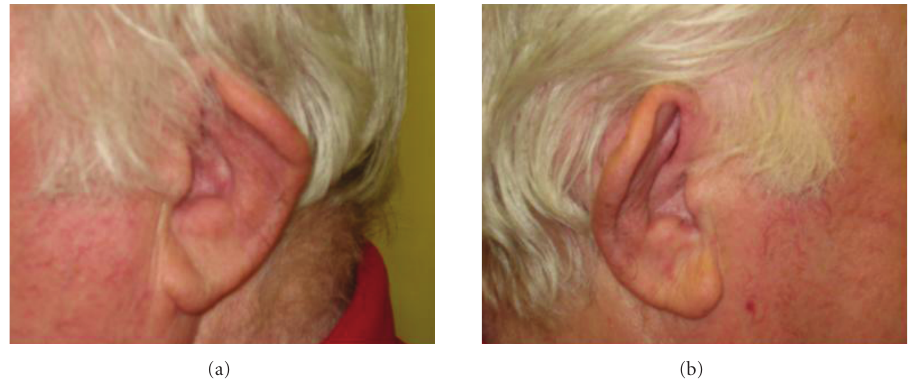
Figure 2: Deformed ear pinnae following the resolution of auricular